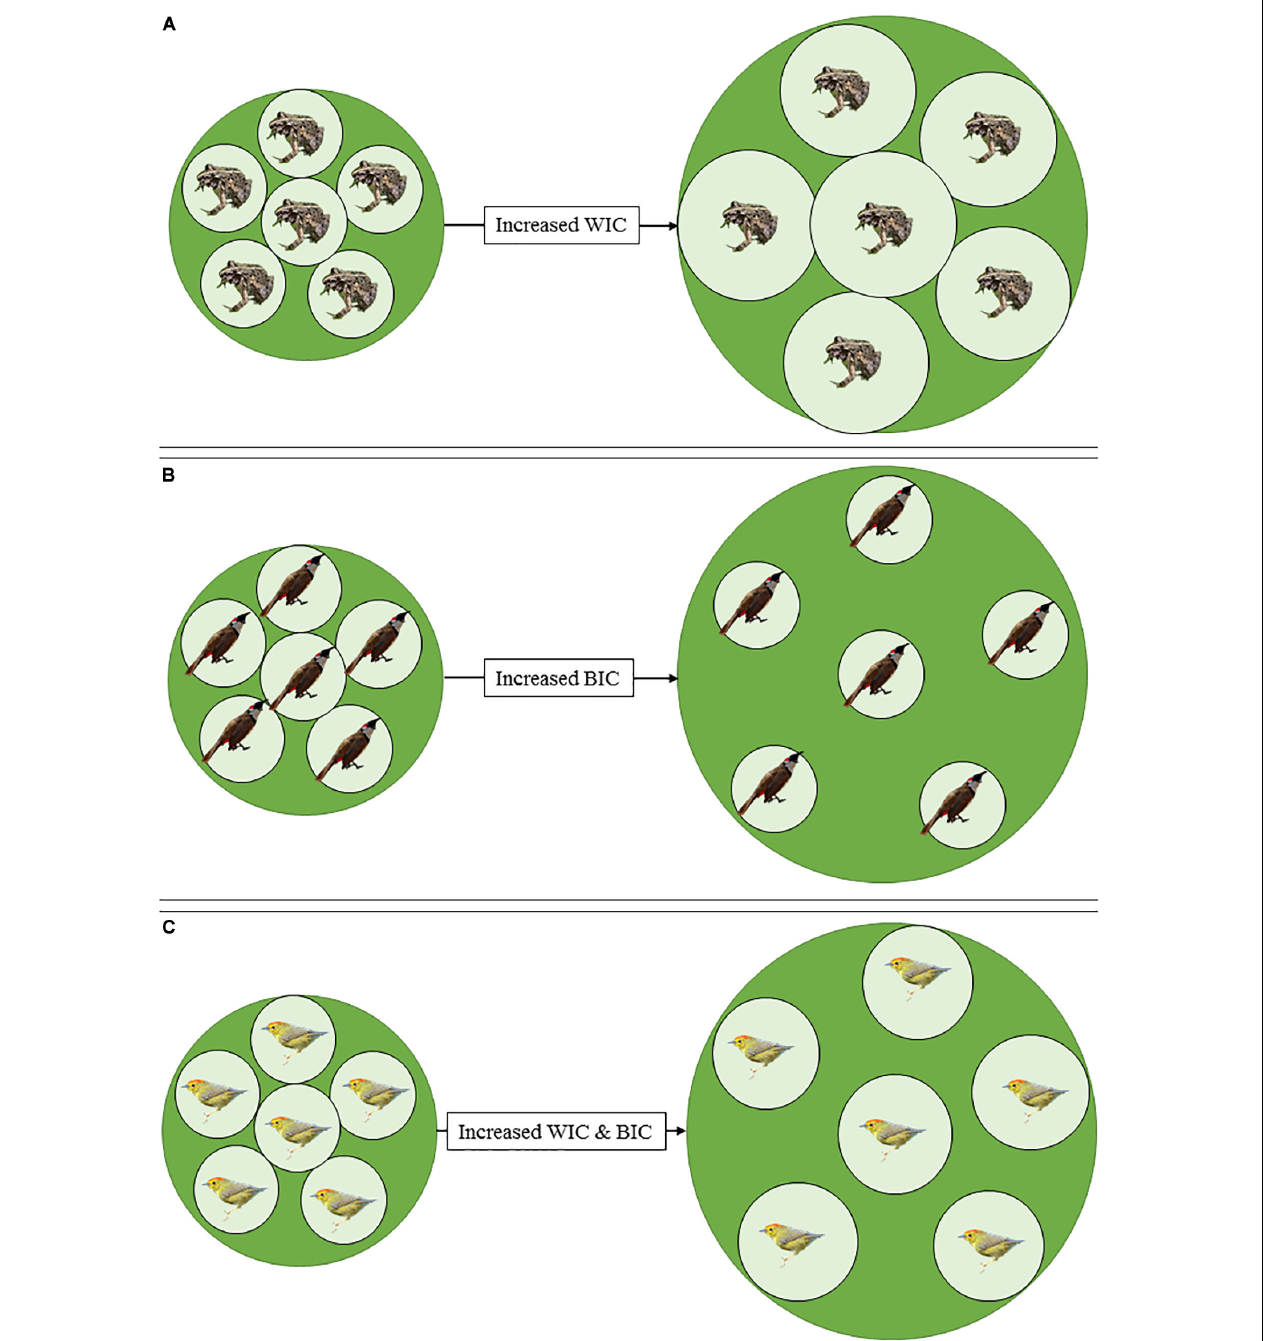
FIGURE 1 | Conceptual illustration of population-level niche expansion resulting from different individual-level niche changes. When population size remains constant, population niche expansion could be achieved through: (A) increased within-individual niche component (WIC), (B) increased between-individual niche component (BIC), or (C) a combination of both processes. Note that increases in individual specialization (IS = WIC/TNW) may or may not be achieved in all these scenarios.